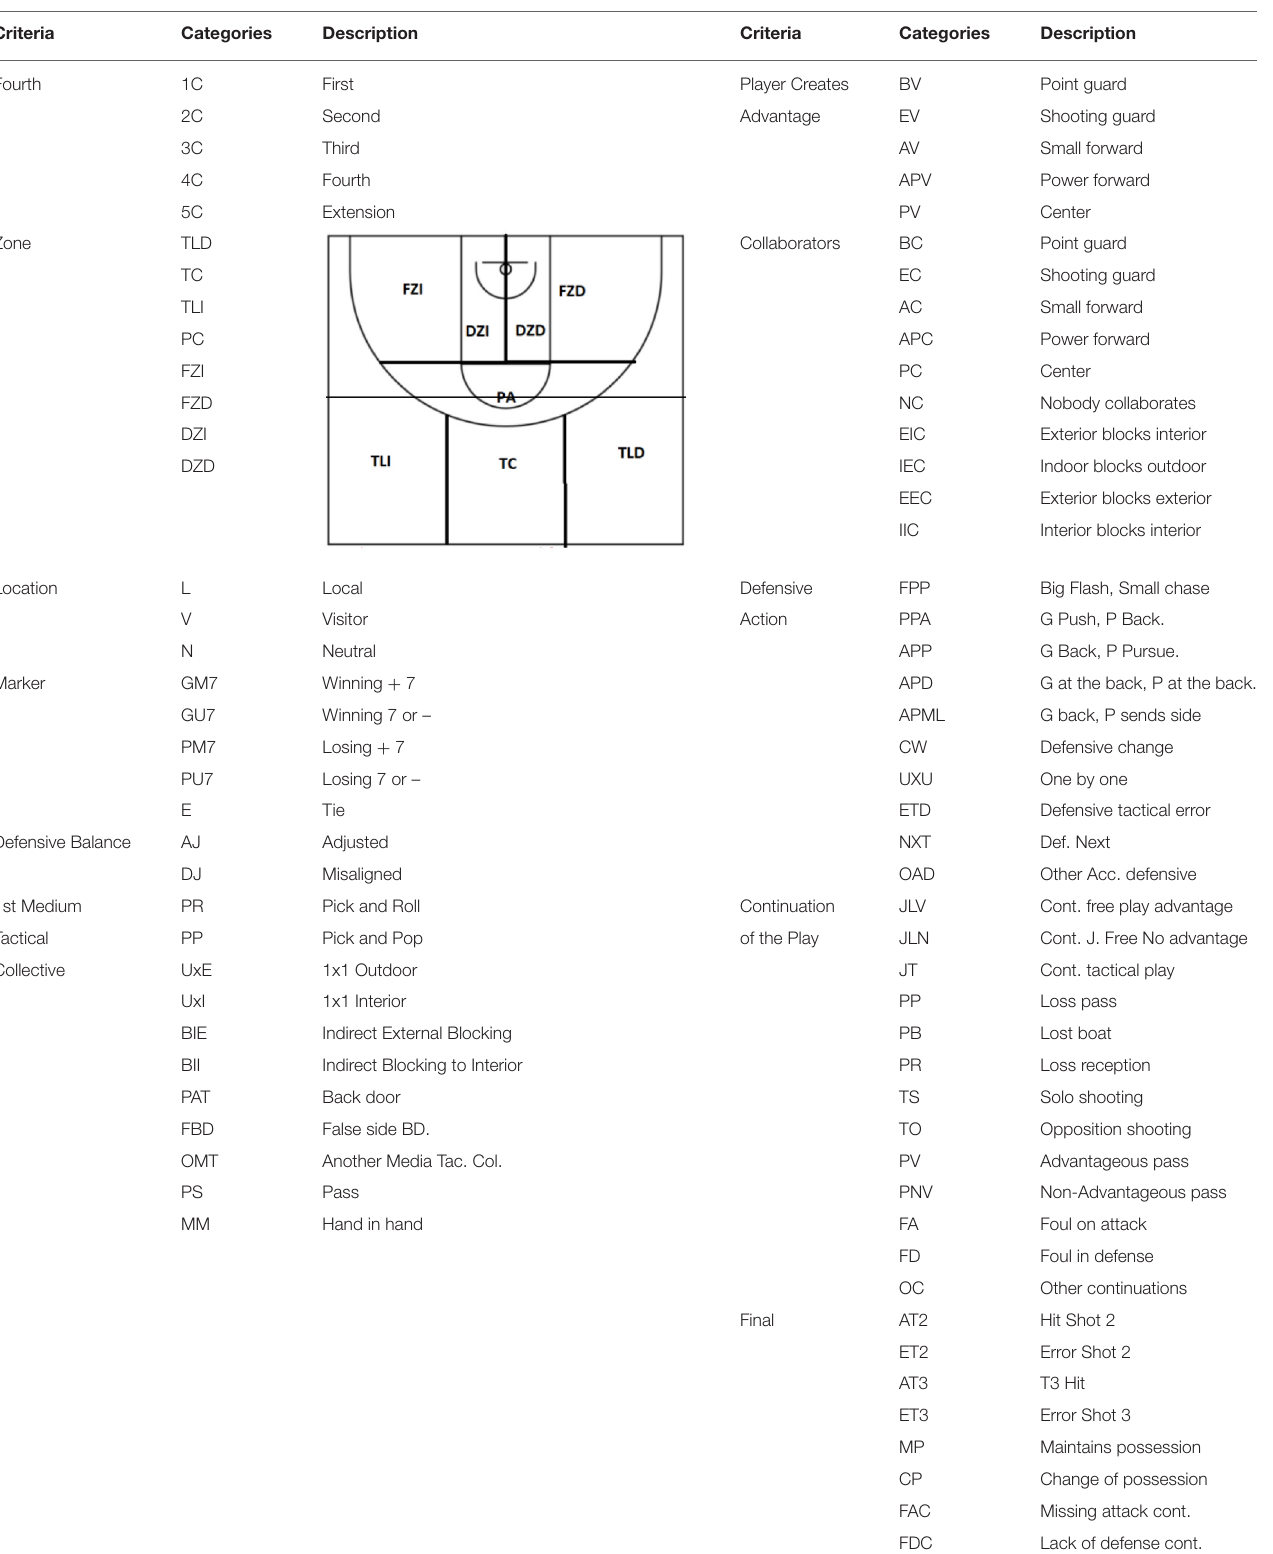
TABLE 2 | Observation instrument for the tactical evaluation of transition play.